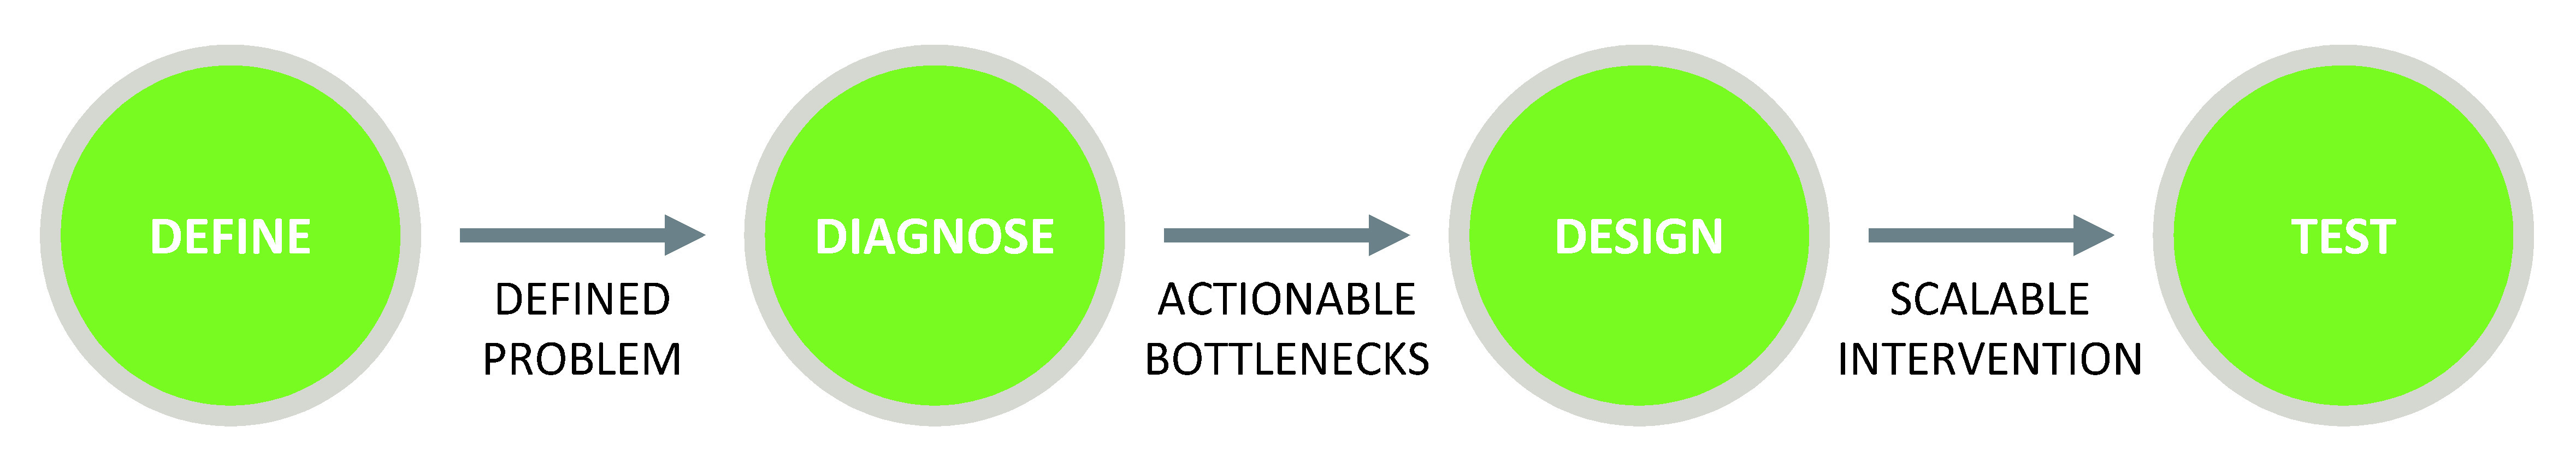
Stages of Behavioral Design methodology (
Datta & Mullainathan, 2014).